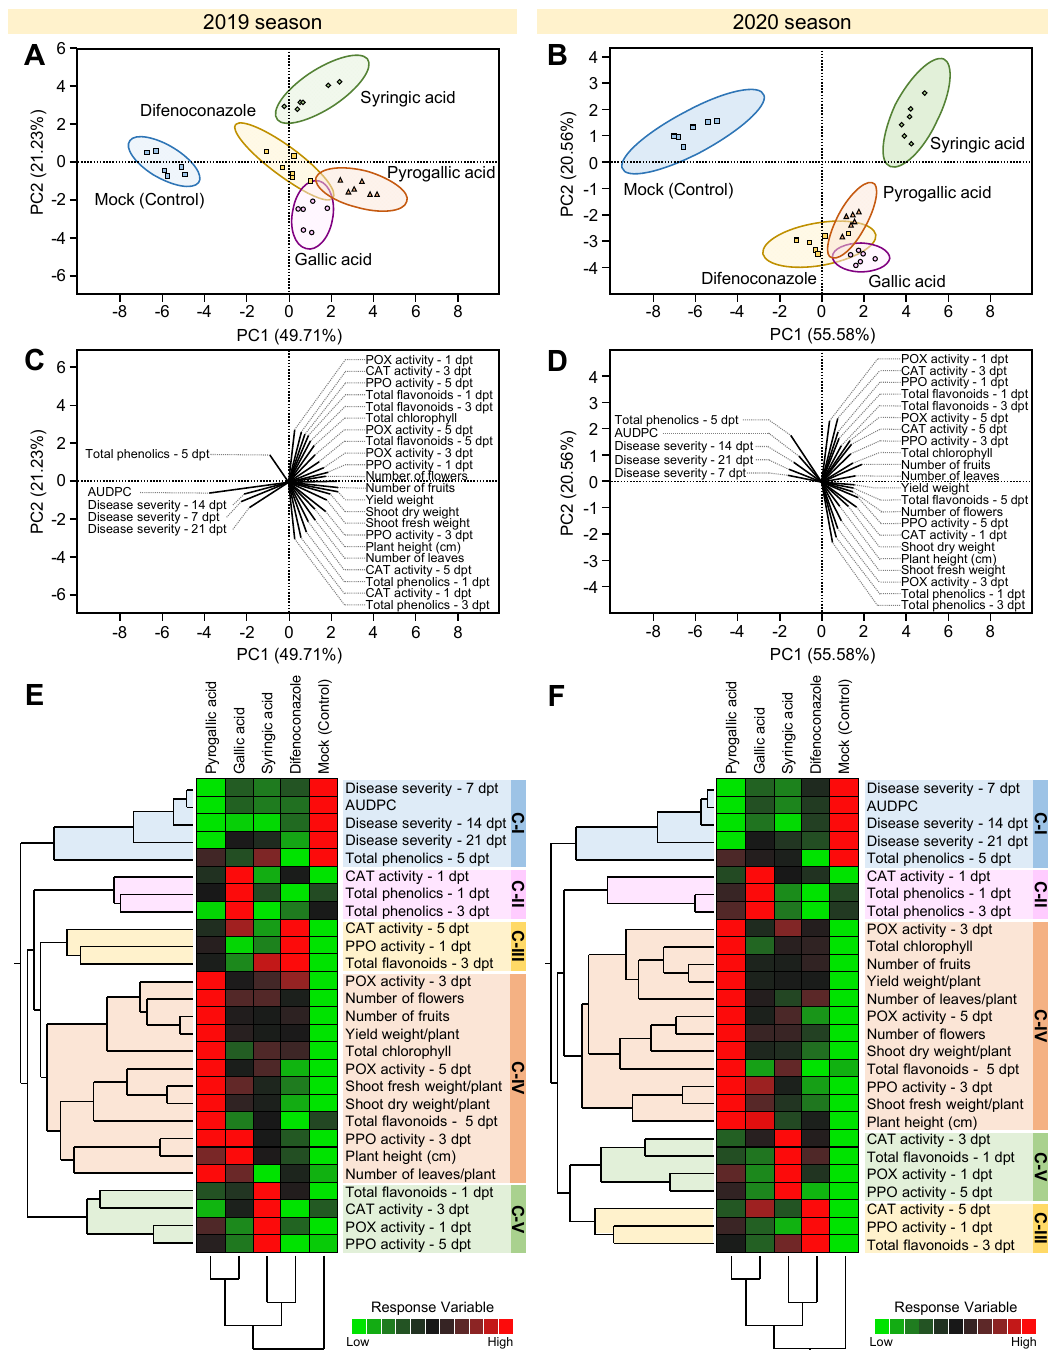
Figure 7. Principal component analysis (PCA) and two-way hierarchical cluster analysis (HCA) of individual response variables assessed in A. solani -infected tomato plants (Super strain B–F 1 hybrid) after the treatment with gallic acid and its derivatives under greenhouse conditions during 2019 and 2020 seasons ( n = 6). ( A , B ) PCA-associated scatters plots during 2019 and 2020 seasons, respectively; ( C , D ) PCA-associated loading plots during 2019 and 2020 seasons, respectively; ( E , F ) two-way hierarchical cluster analysis (HCA) during 2019 and 2020 seasons, respectively. The differences in the response variables between all studied treatments are visualized in the heat map diagram. Rows represent the individual response variables, while columns represent the treatments. Lower numerical values are colored green, whereas higher numerical values are colored red (see the scale at the right corner of the bottom of the heat map).